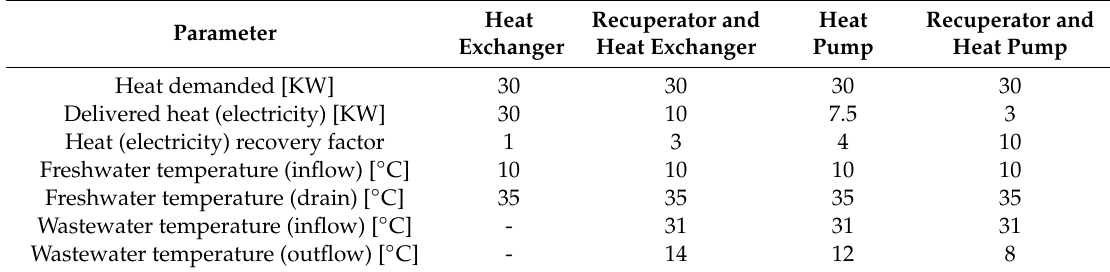
Table 4. Comparison of installation schemes for freshwater